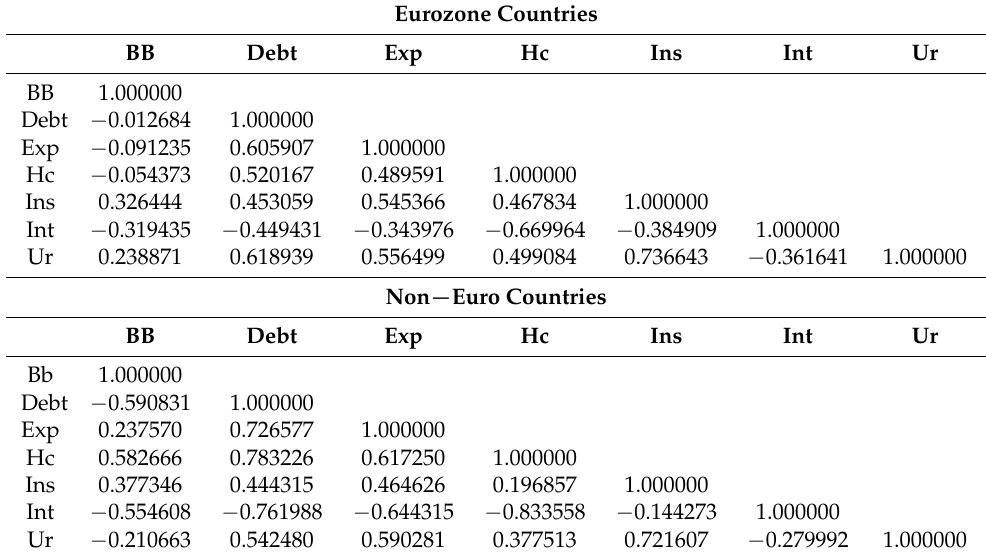
Table 9. Correlation matrix: BB, Debt, Exp, Ins, Hc, Ur and Int (eurozone countries and noneuro countries).